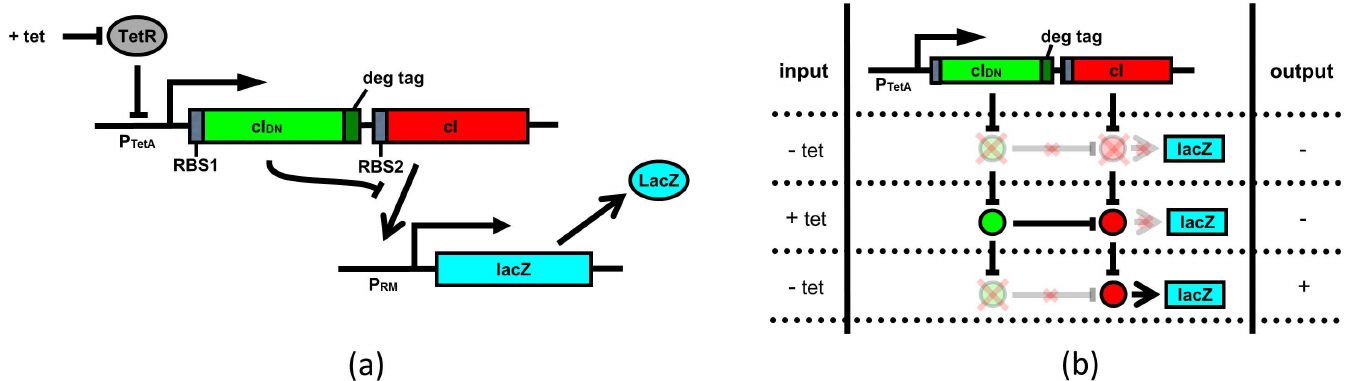
Fig 1. Schematic representation of the negative edge triggered pulse detecting circuit. (a) Components of the pulse detectingcircuit. The central elementis an artificial operonin which a regulatedpromoterdirects transcription of high levels of an unstableinhibitorprotein and lower levels of a target transcriptional regulator.In the specific versionshown here, the tetracycline-regulatedTetA promoter directs transcription of, firstly, a dominant-negative mutant of the lambda cI gene with a degradationtag (green), and secondlyan intact versionof the cI gene (red). TetR, the tetracylinerepressor (gray), blocks transcription of this unit and P RM (which is activated by intact CI protein) transcribing lacZ (sky-blue) serves as an illustrative readout of circuit activity. (b) Behavioralcharacteristics of the circuit in responseto an inducingpulse, with time proceedingdownward.In the initial absenceof the inducer tetracycline, neither of the proteins is made and lacZ is OFF. Upon additionof tetracycline, both proteins are made and the CI DN protein inhibitsthe wild-type protein, so lacZ remainsOFF. Upon removalof the inducer, the CI DN protein is rapidly degradedwhilethe wild-typeCI protein remains intact, and activates lacZ